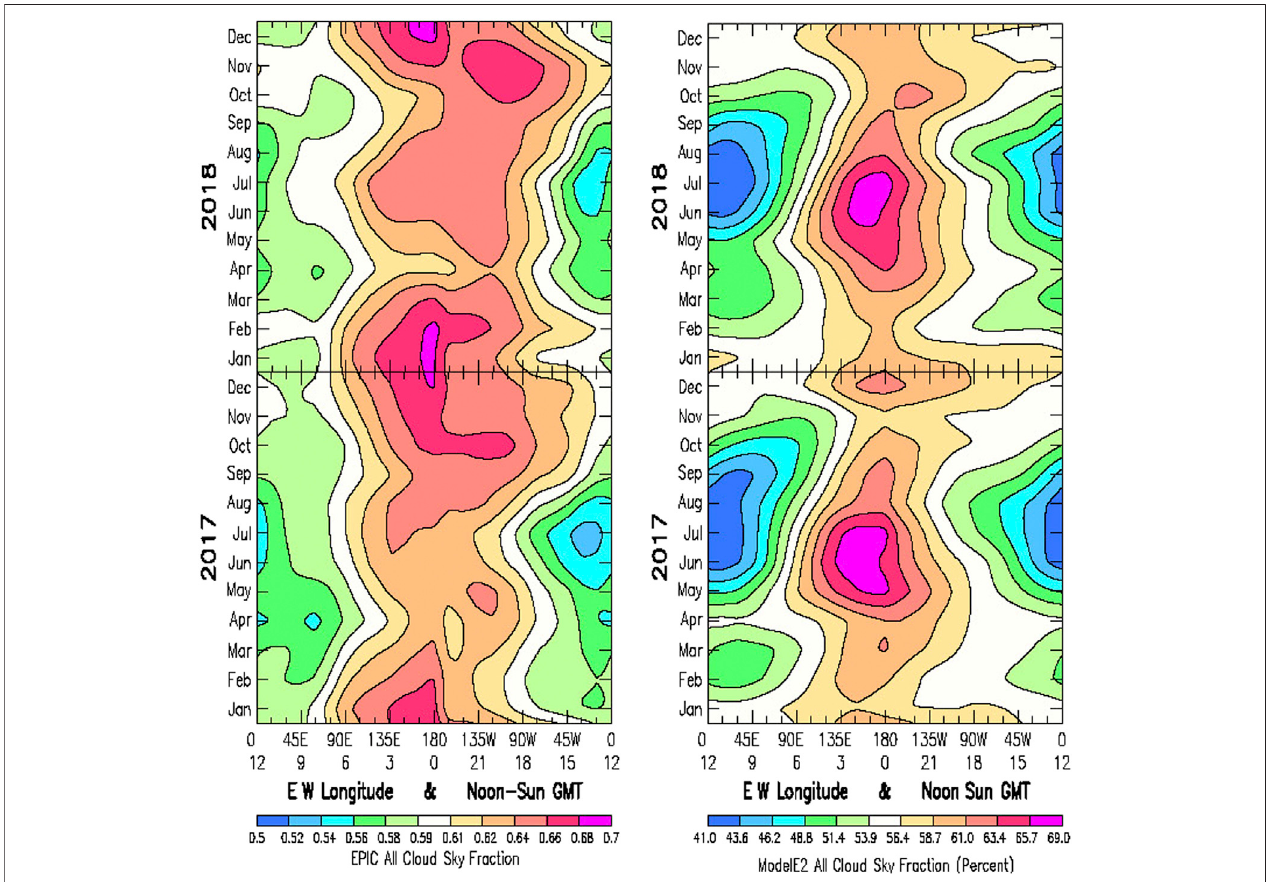
FIGURE 6 | Hovmöller plots of the EPIC (Left) and ModelE2 (Right) cloudy sky fraction for 2017 and 2018. The Y-scale has time running upward starting with January2017atthebottomthroughDecember2018atthetop.TheX-scaleislongituderunningfrom0 ° Elongitudeattheleftand0 ° Wlongitudeattheright.TheX-scale references the GMT of the noon-time Sum, starting at GMT = 0 at the Date Line at the center, proceeding westward to the left as the Earth rotates. In the color bar, magenta identi fi es the highest cloud fractions, deep blue the lowest.